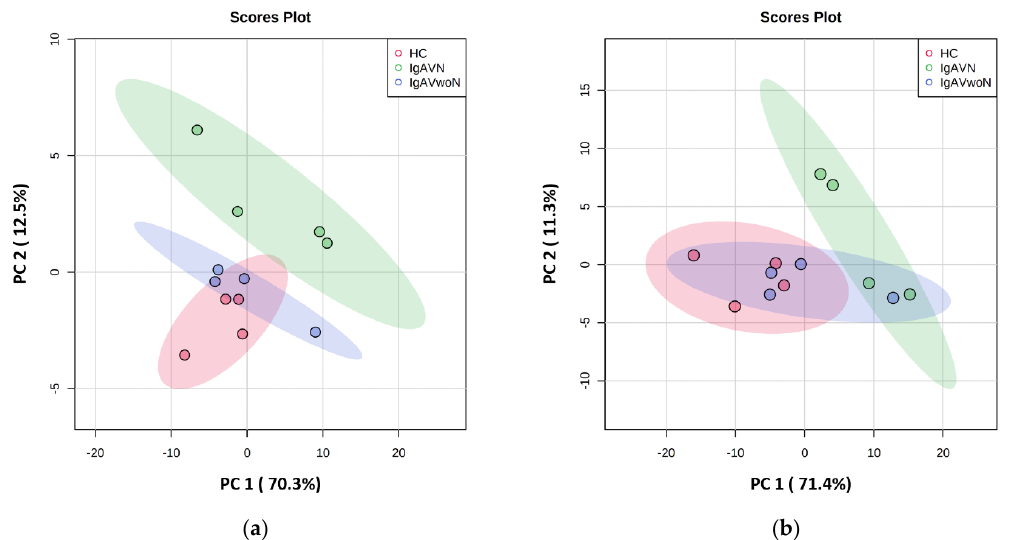
Figure 1. Exploratory data analysis representation: ( a ) Kit K: scores plot between principal component (PC) 1 and PC2 with the explained variance shown in brackets; ( b ) Kit C: scores plot between PC1 and PC2 with the explained variance shown in brackets.